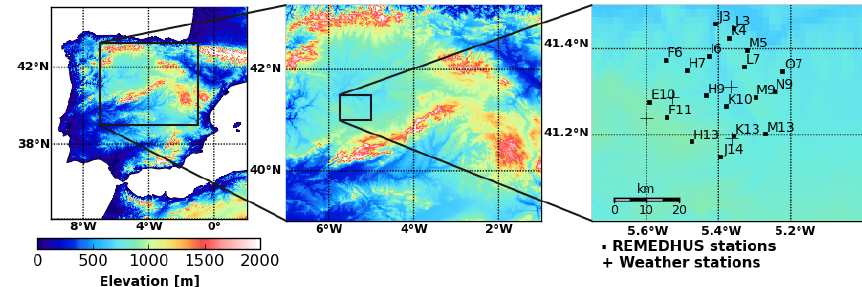
Figure 1. Quick view of the study area in central Spain and the location of the REMEDHUS observation network.